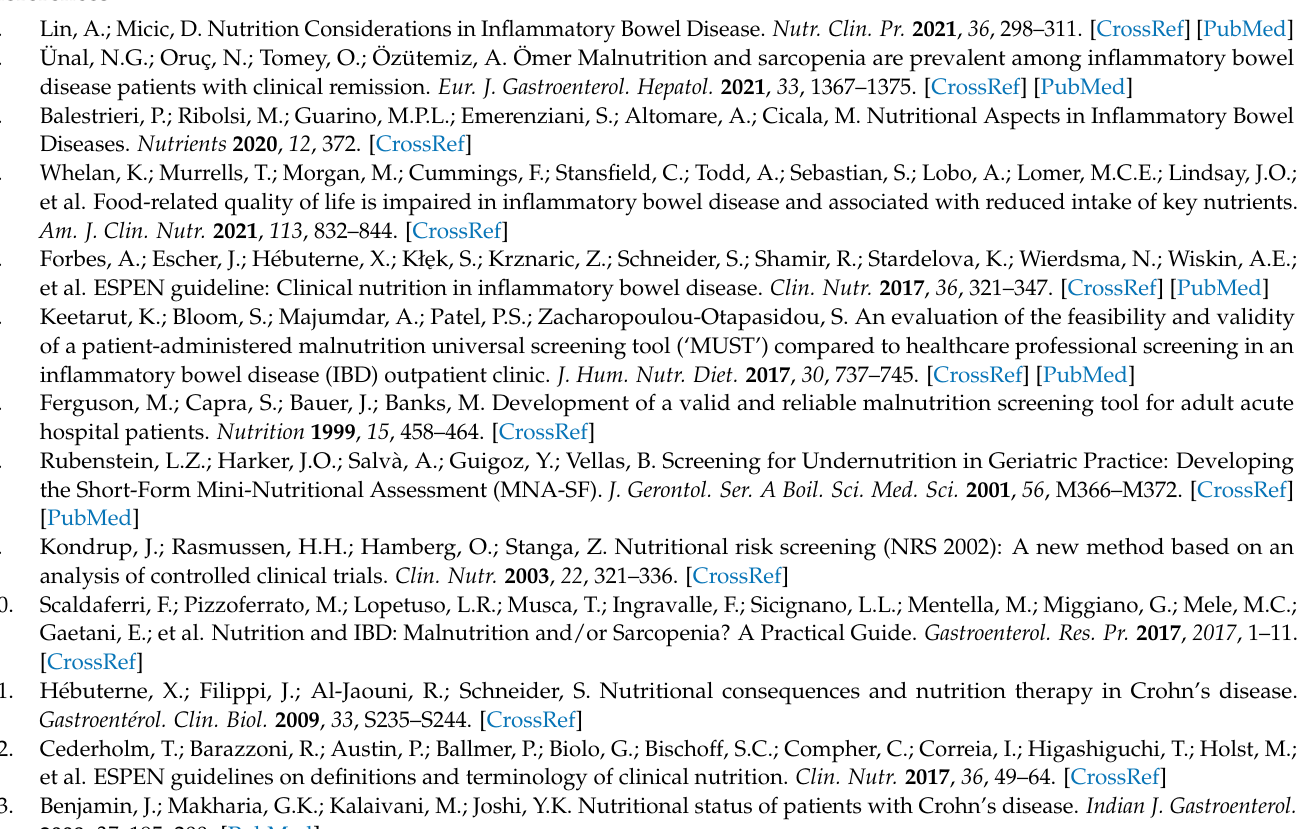
Table S2: Demographic and clinical characteristics of the study population at the index visit. Table S3: Adjusted associations between disease and patient characteristics and malnutrition development. Table S4: The association between the number of IBD-MRfactors and malnutrition preventive inter-